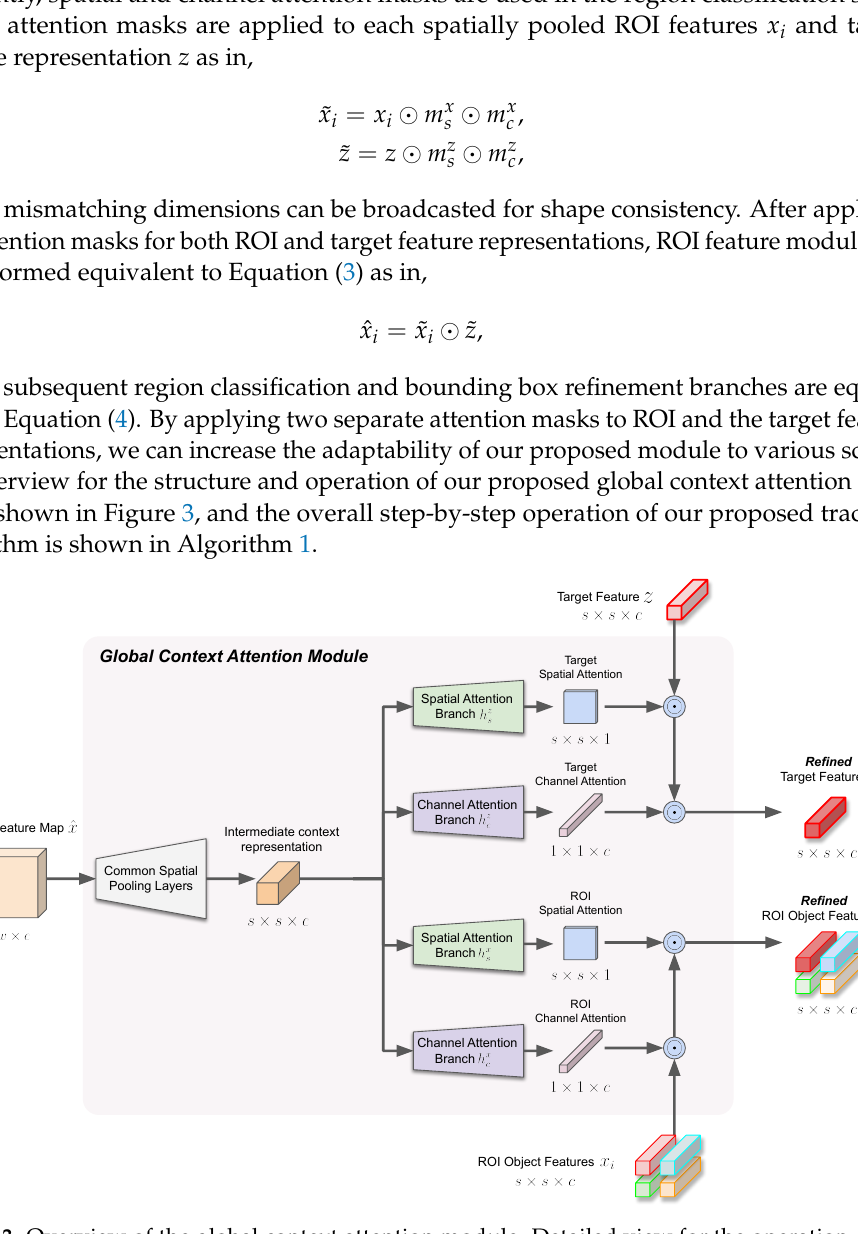
Figure 3. Overview of the global context attention module. Detailed view for the operation of the proposed global context attention